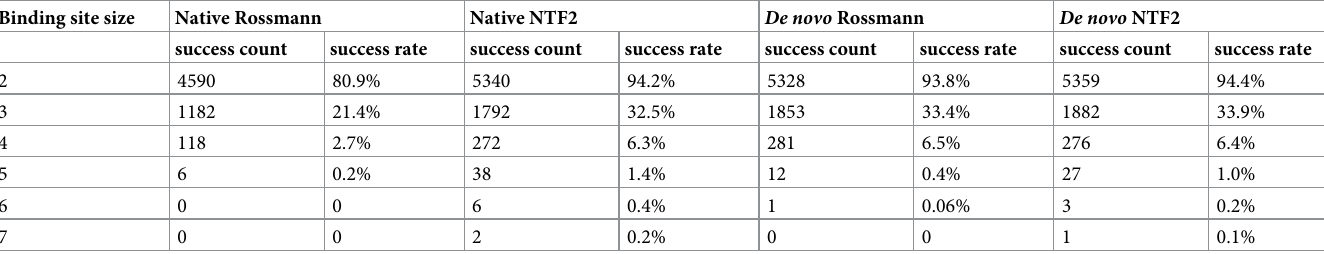
Table 2. Dependency of matching success on binding site size (number of protein